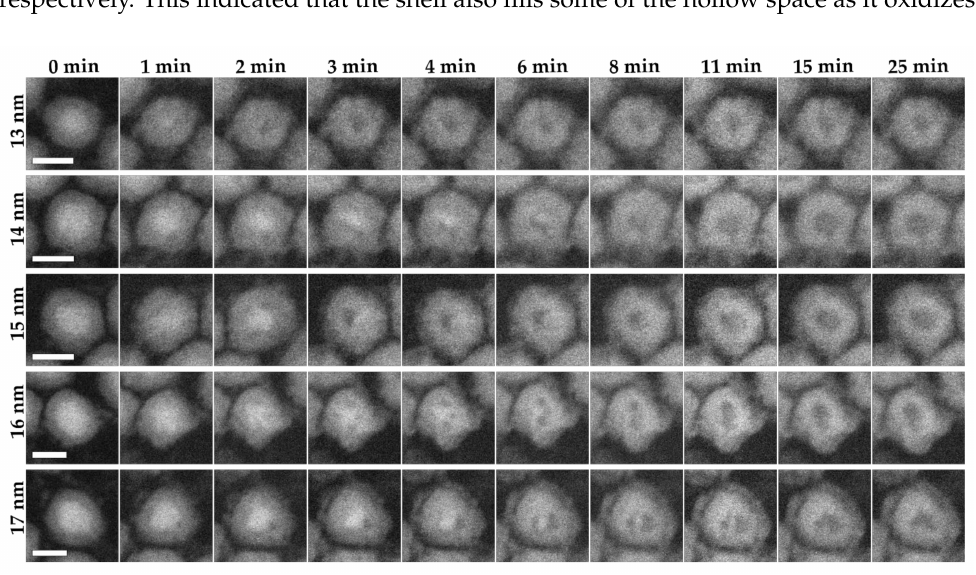
Figure 3. In situ visualization and analysis of dynamic oxidation of Fe nanoparticles in HAADF- ESTEM at 200 ◦ C with 2 Pa oxygen. The figure shows nanoparticles with increasing particle sizes (13–17 nm) over a period of 25 min. The images have a 10 nm scale